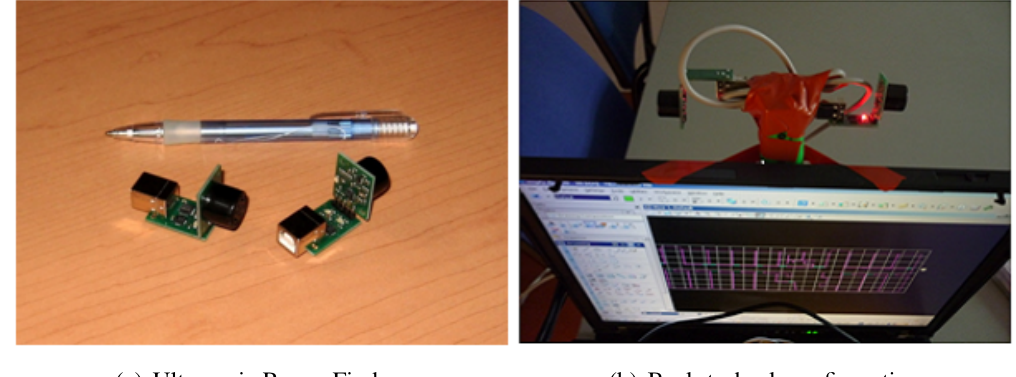
Figure 8. (a) The two ultrasound range sensors connected to the USB interface modules. (b) The two sensors in a back-to-back configuration installed on top of the portable computer carried by the